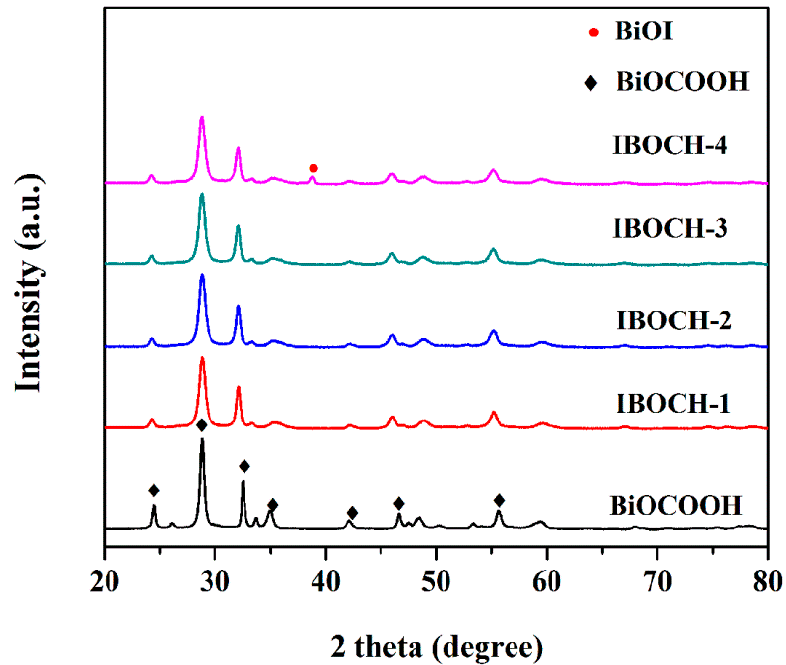
Figure 1. XRD patterns of BiOCOOH, and as-fabricated BiOI/BiOCOOH heterojunctions (IBOCH-1, IBOCH-2, IBOCH-3, and IBOCH-4).